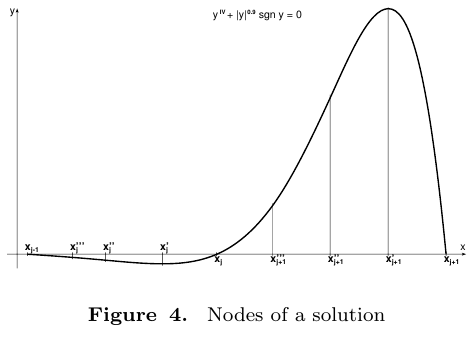
Figure 4. Nodes of a